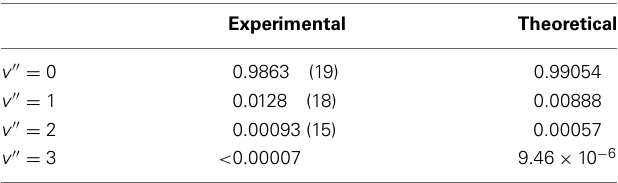
Table 1 | Probabilities for decay from A 1 (cid:2) ( v (cid:2) = 0) to X 1 (cid:3) + ( v (cid:2)(cid:2) ). Experimental